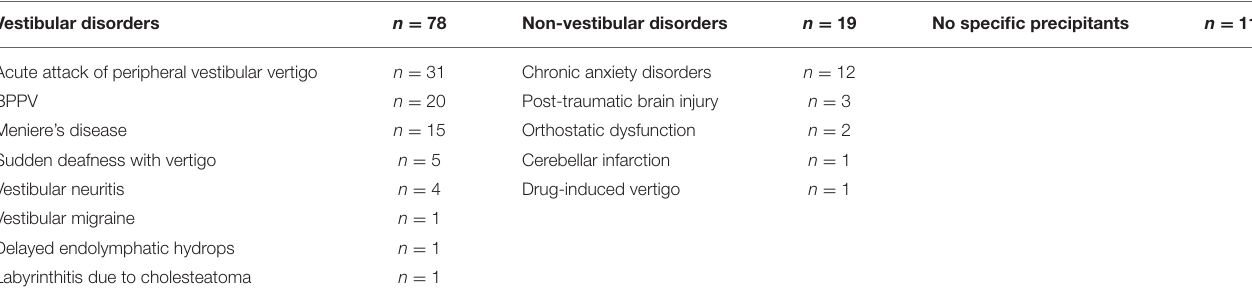
TABLE 1 | Precipitating conditions for patients with persistent postural-perceptual dizziness ( n ). Vestibular disorders n = 78